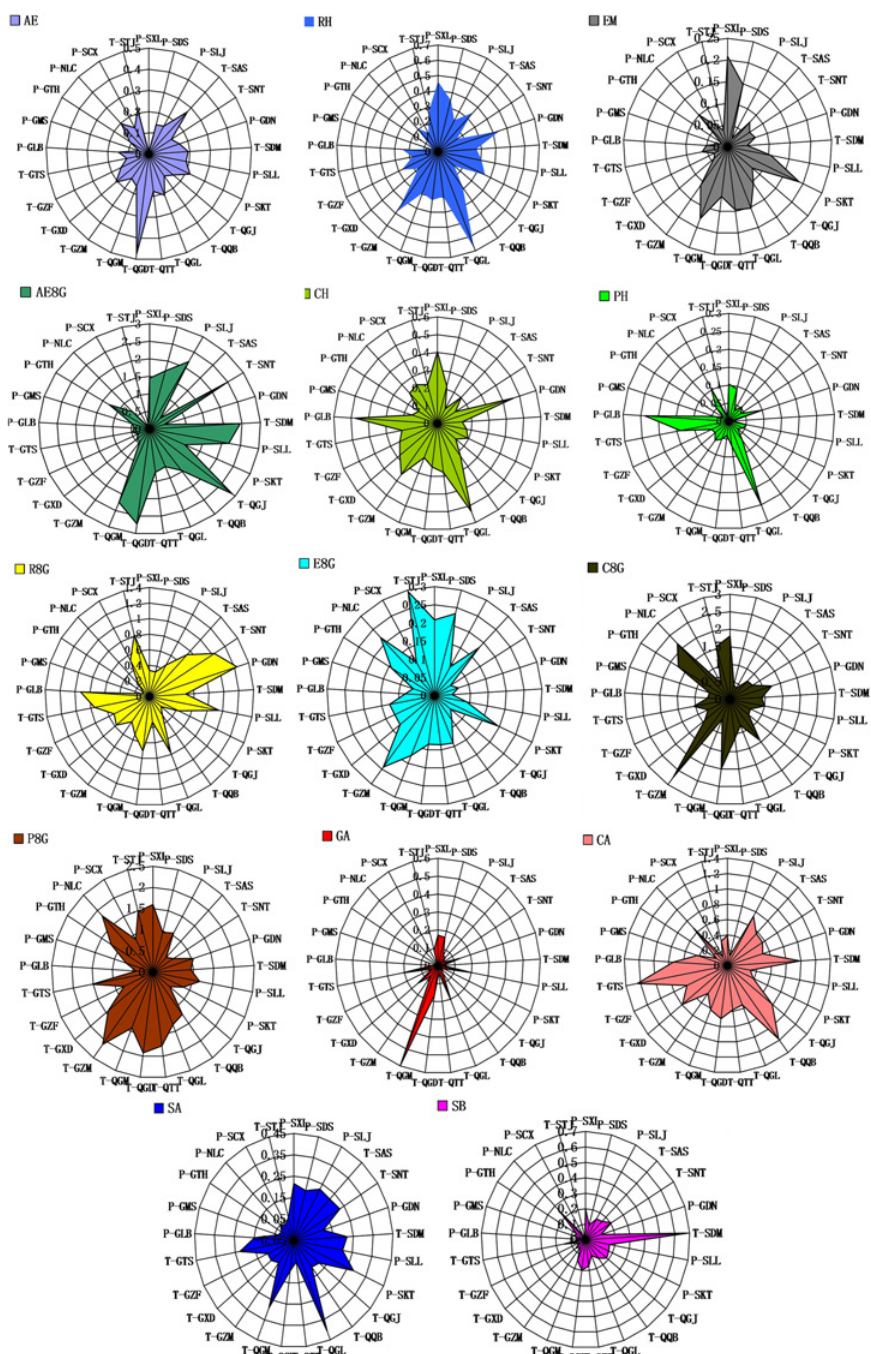
Fig 2. Comparison of the contents of API in rhubarb from different